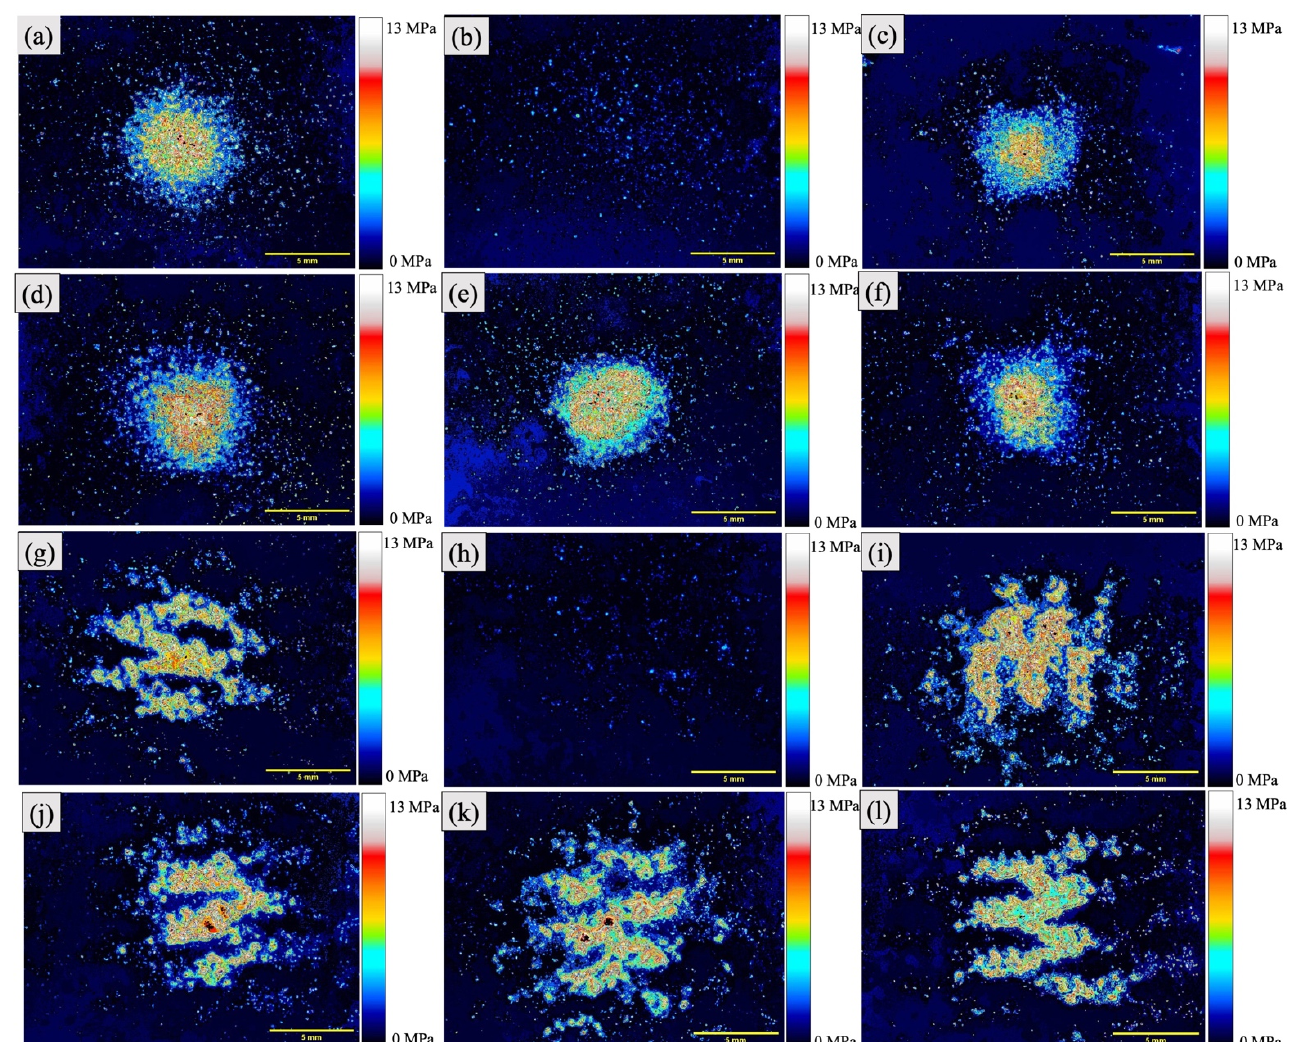
Figure 9. Pressure distribution obtained using pressure measurement films. ( a ) AP0 + NEO, ( b ) ABS0 + NEO, ( c ) ABS10S + NEO, ( d ) ABS10 + NEO, ( e ) ABS20S + NEO, ( f ) ABS20 + NEO, ( g ) AP0 + AKE, ( h ) ABS0 + AKE, ( i ) ABS10S + AKE, ( j ) ABS10 + AKE, ( k ) ABS20S + AKE, and ( l ) ABS20 + AKE.